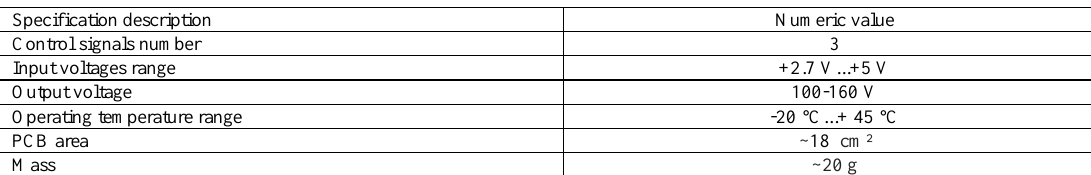
Table 1. The developed driver’ principal technical